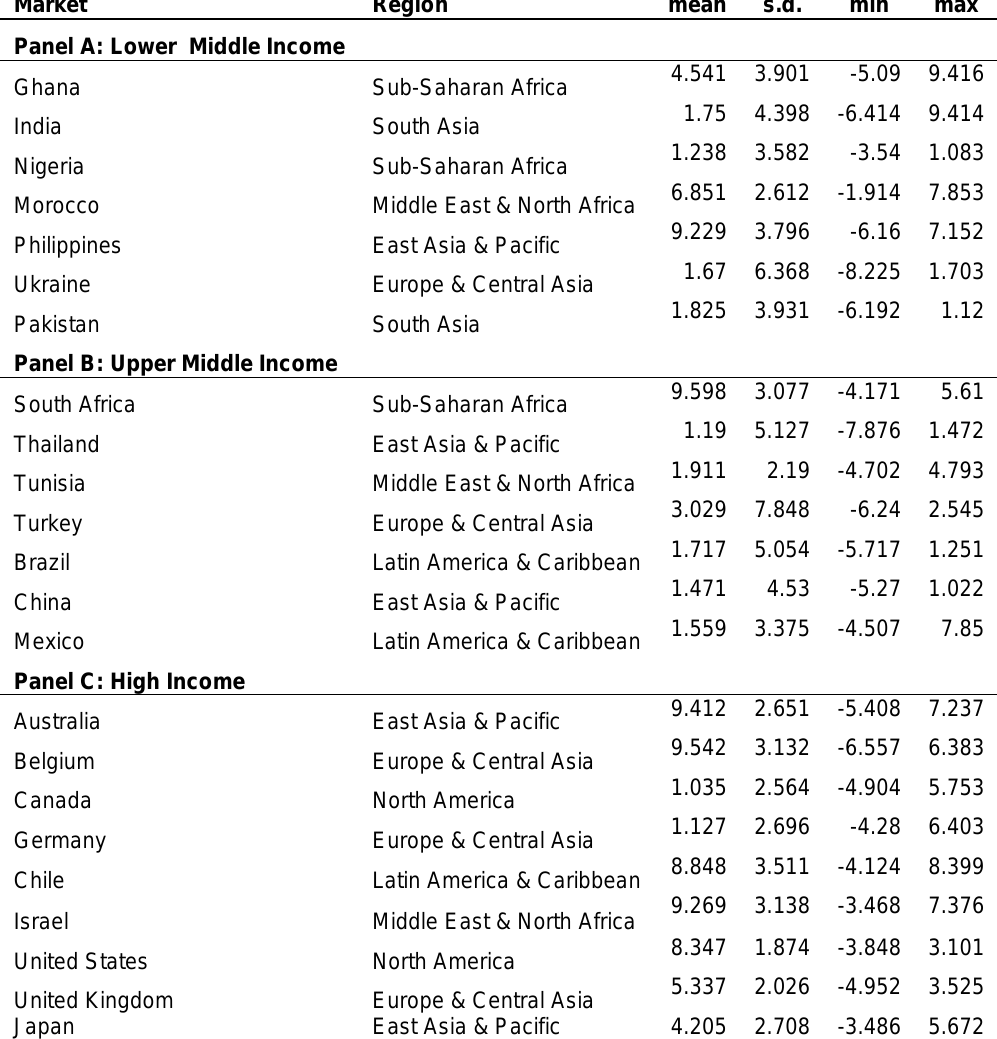
Table 3. Summary statistics of stock returns per income classifications from 1996 to